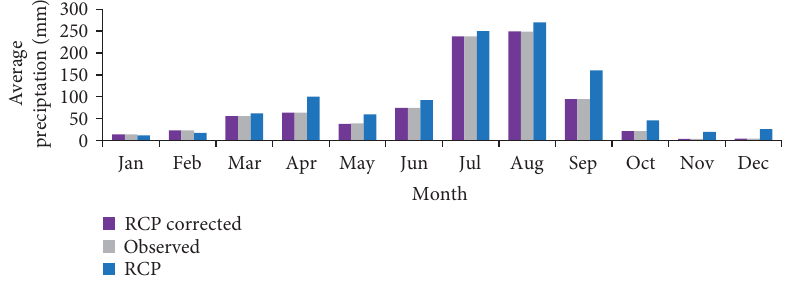
Figure 4: Bias correction of average monthly precipitations.